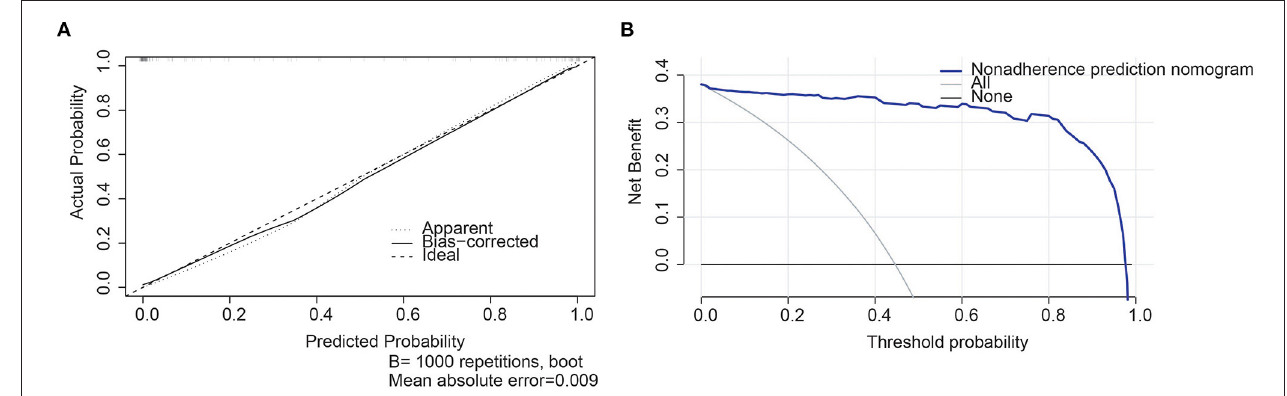
FIGURE 5 | (A) Calibration plots for predicting MS. X-axis: bootstrap-predicted; y-axis: actual outcome, (B) Decision curve analysis (DCA) of the novel nomogram for predicting MS. X-axis: cut-off probability; y-axis: net